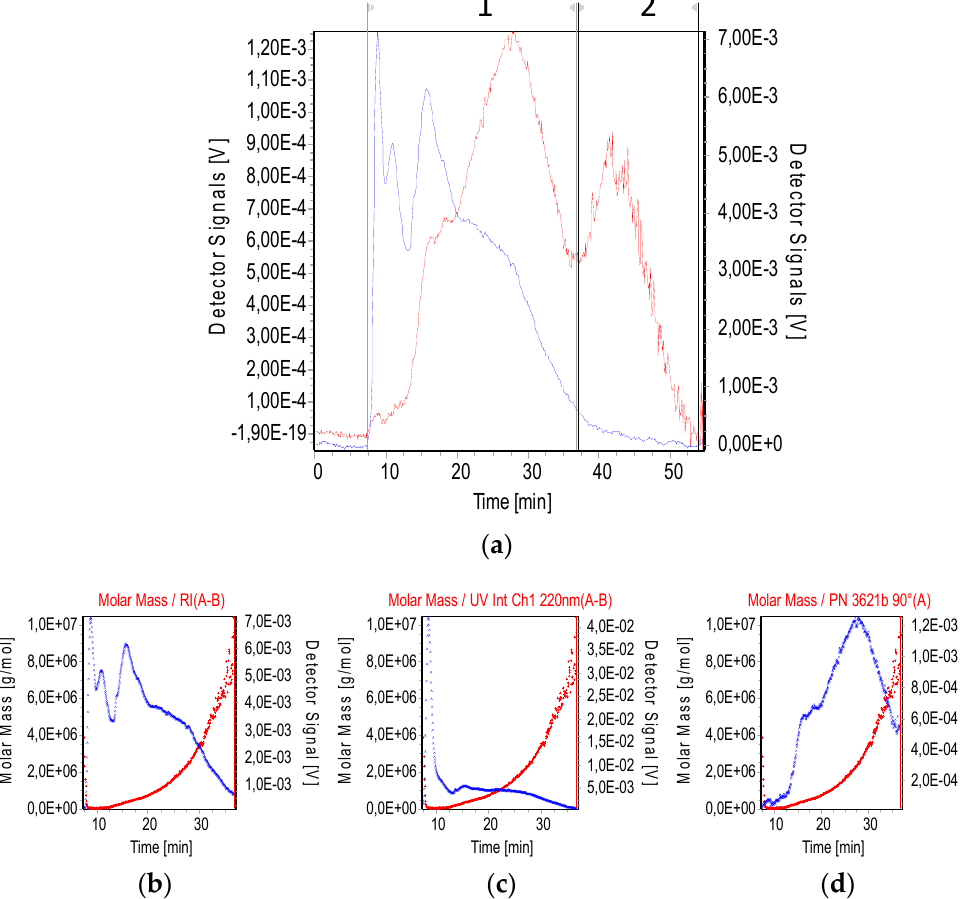
Figure 3. Measurement of mucin by asymmetrical flow field-flow fractionation (AF4); refractive index (blue) and MALS at 90° (red) signals recorded by AF4 of mucin type III from Sigma Aldrich ( a ). Analyses of region 1 of the recording: Mucin: RI ( b ), UV absorbance at 220 nm ( c ), and light scattering at 90° ( d ). In all the analyses, molar mass is included. Table 1. Physico-chemical parameters of the mucin particles analysed by AF4.